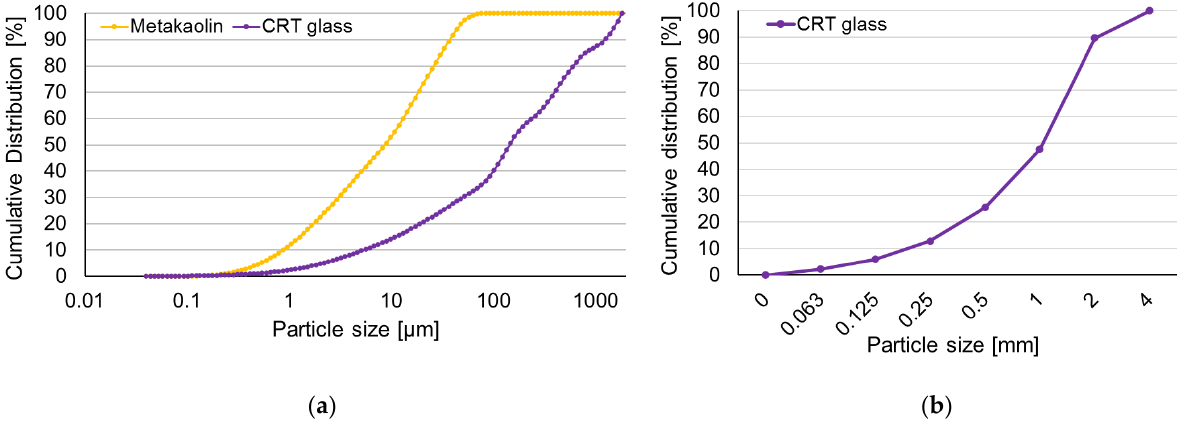
Figure 1. ( a ) The particle size distribution of the fine grains of CRT glass and metakaolin and ( b ) the particle size distribution of CRT glass.